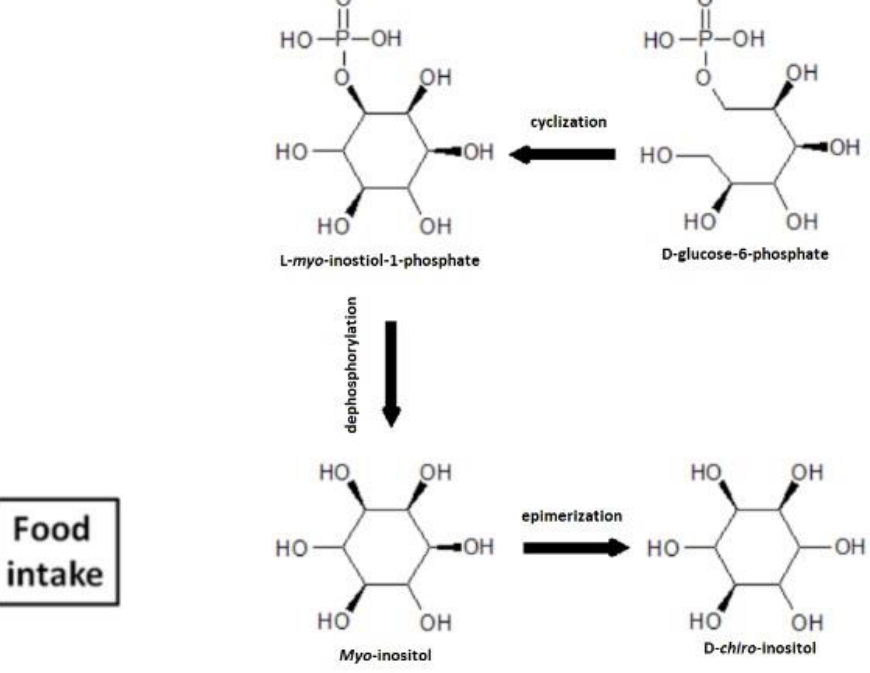
Figure 1. Cyclization, dephosphorylation and epimerization of MI.